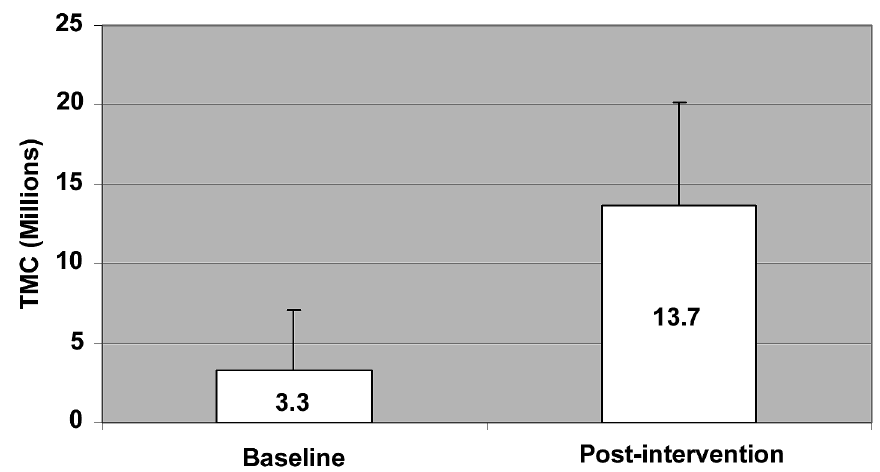
Figure 1 – Mean total motile count (TMC) in responders cohort for baseline and > 3 months post-intervention. Bars represent standard deviation.